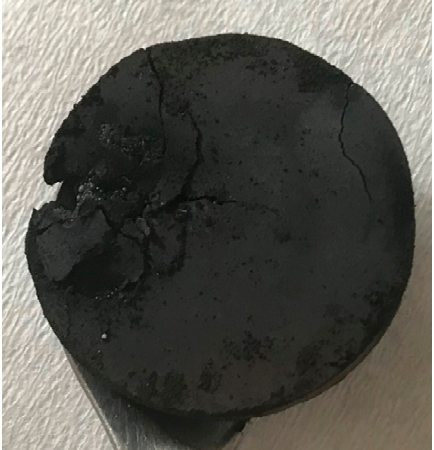
Figure 8. Tablet after 300 s irradiation time at 0.6 kW, C / BR 0.180, and 1 L / min nitrogen flow.